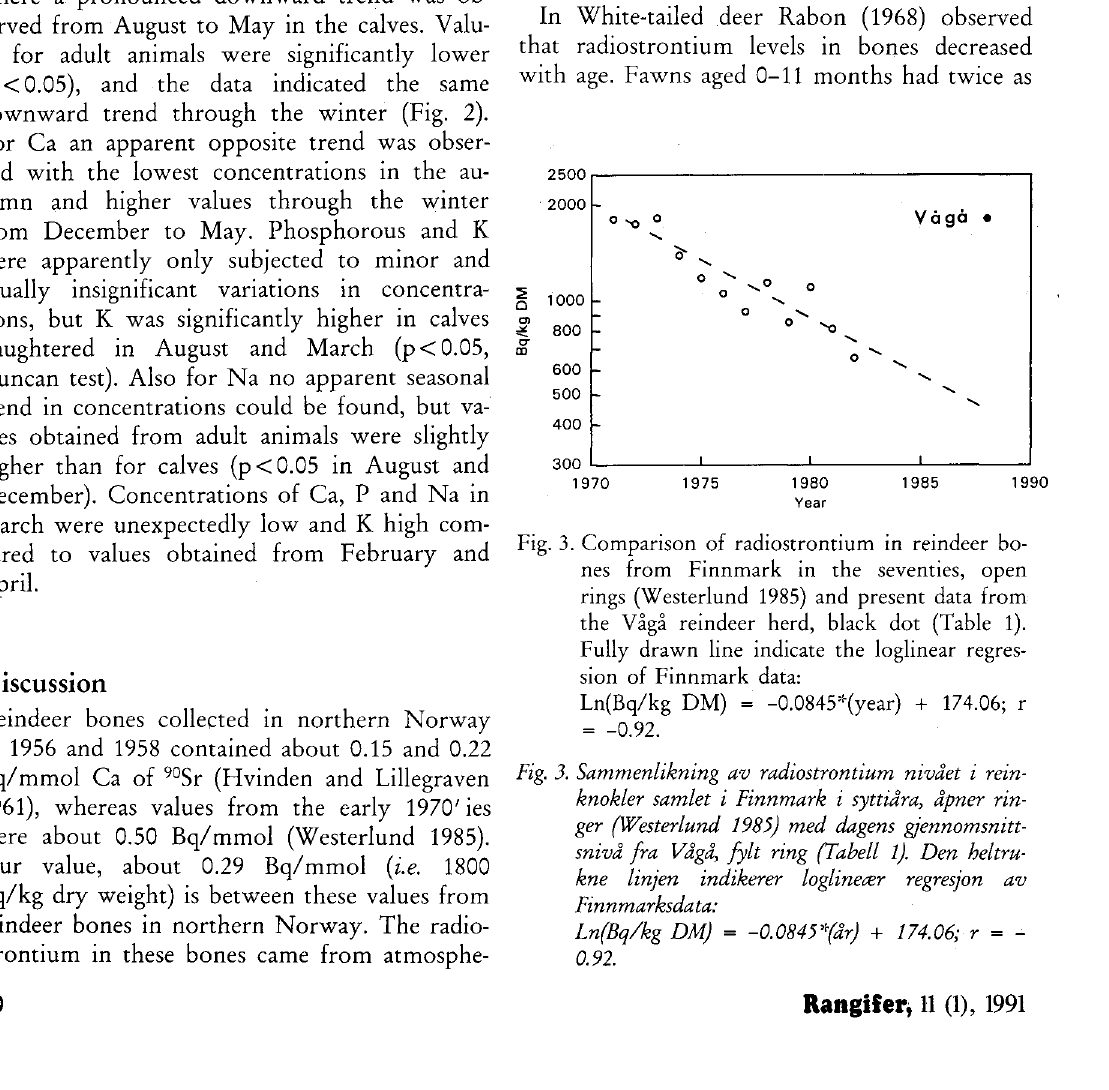
Fig. 3. Comparison of radiostrontium in reindeer bo nes from Finnmark in the seventies, open rings (Westerlund 1985) and present data from the Vågå reindeer herd, black dot (Table 1).